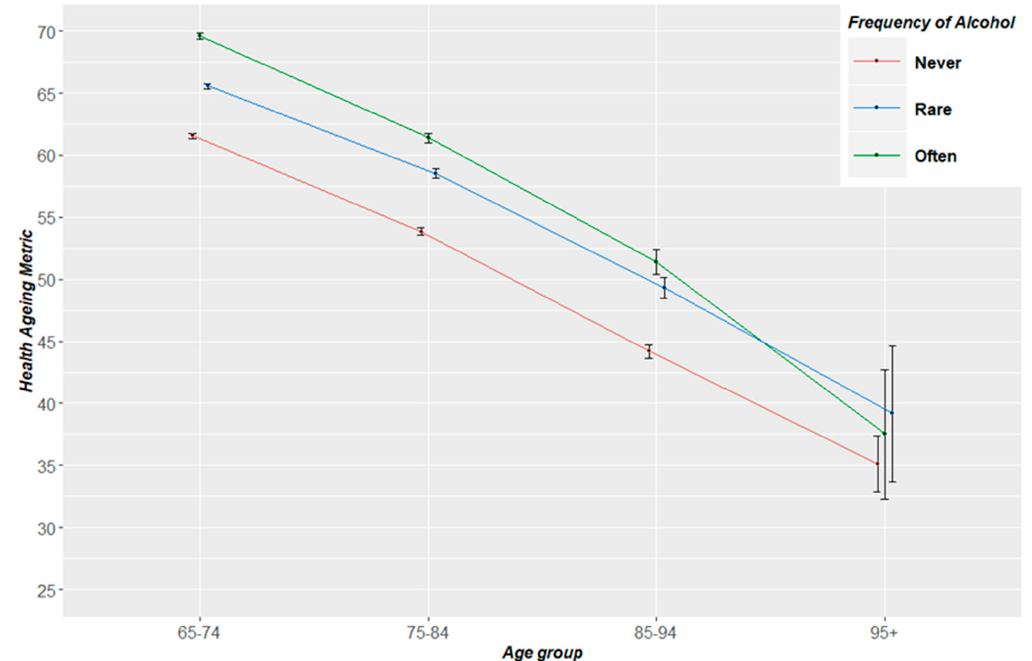
Figure 1. Trajectories of health status from the ages of 65 to 95+ years old, by frequency of alcohol drinking for the total ATHLOS sample. Health ageing metric ranges from 0–100; Ageing Trajectories of Health: Longitudinal Opportunities and Synergies (ATHLOS).